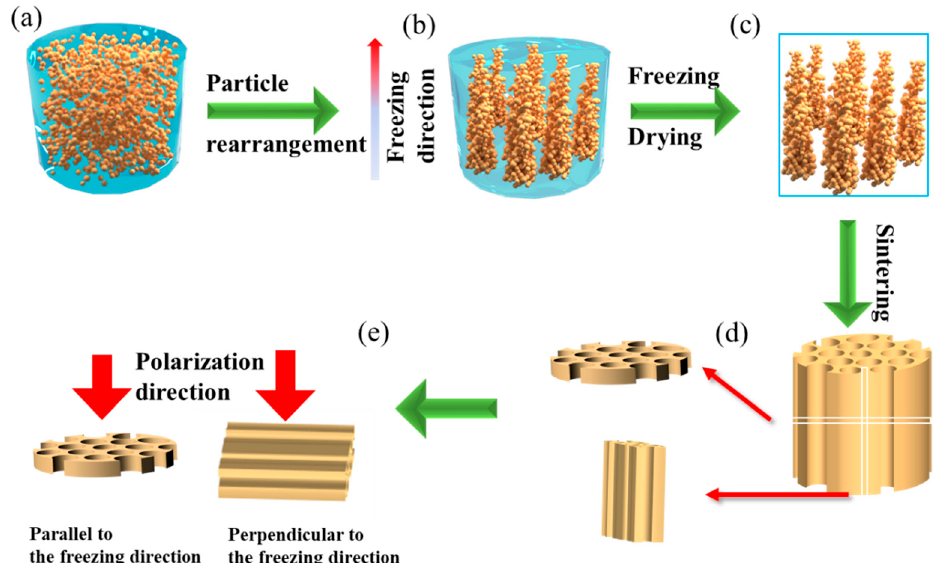
Figure 1. Schematic diagram of porous BCZT piezoelectric ceramics prepared by freeze casting. ( a ) slurry preparation, ( b ) slurry freezing solidification and particle rearrangement, ( c ) sublimation drying gives porous ceramic blanks, ( d ) sintering and cutting samples, ( e ) the samples with a direction of polarization parallel or perpendicular to the freezing direction are defined as parallel samples or perpendicular samples.